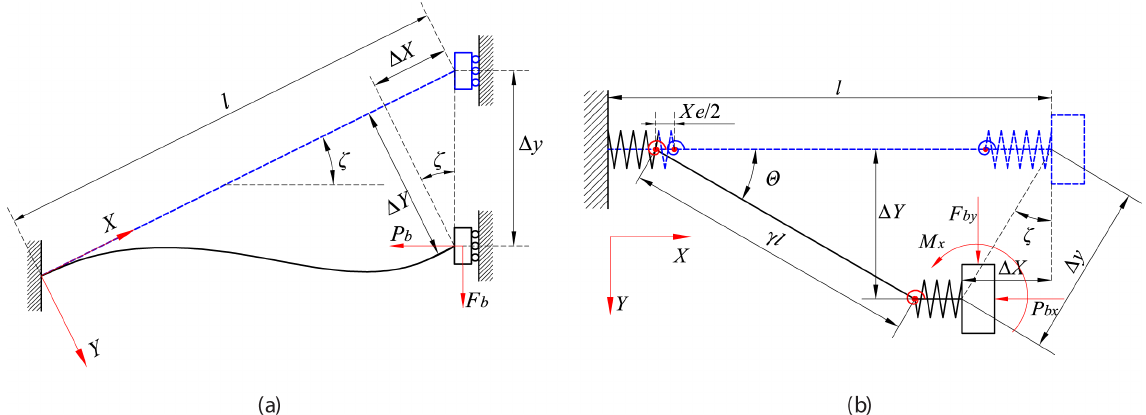
Figure 11. A fixed-guided beam in the bistable mechanism. (a) Schematic diagram. (b) MPRB model.